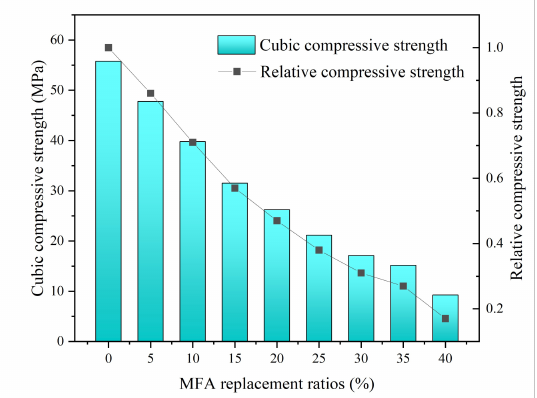
Figure 6. Cubic compressive strength versus MFA replacement ratios.